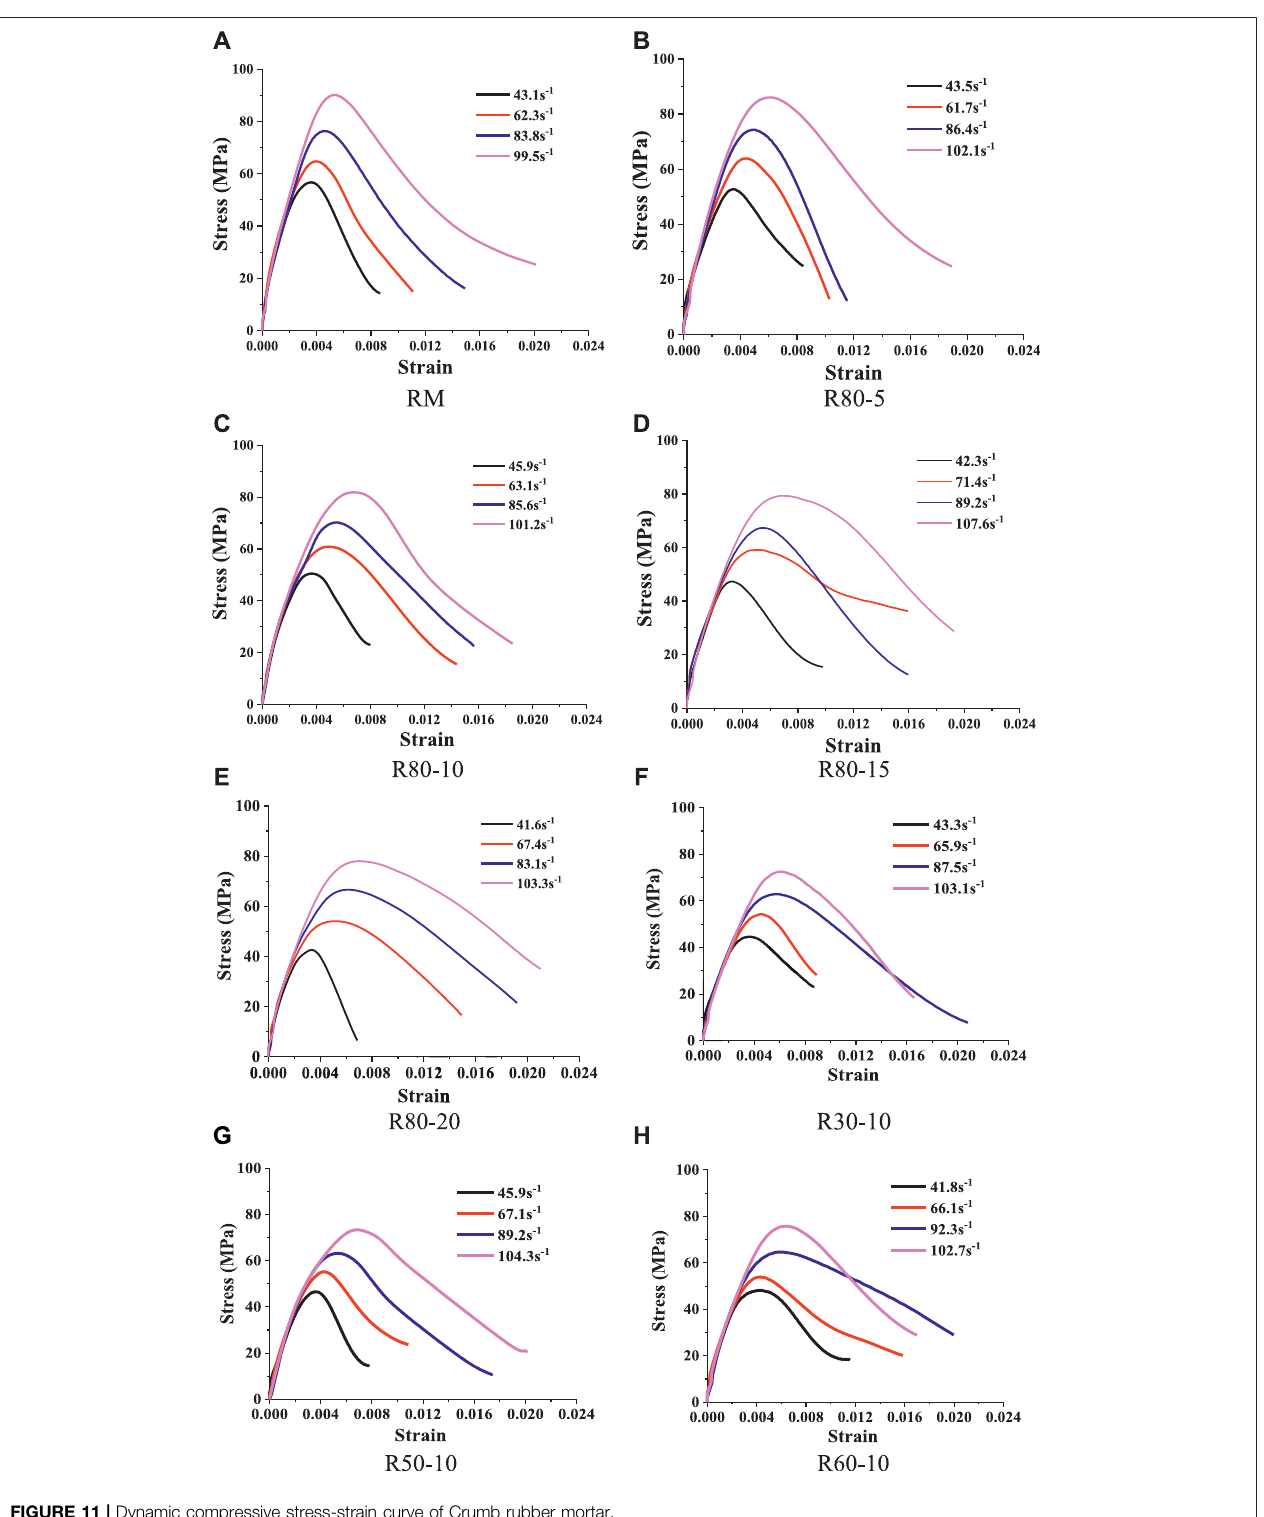
FIGURE 11 | Dynamic compressive stress-strain curve of Crumb rubber mortar.